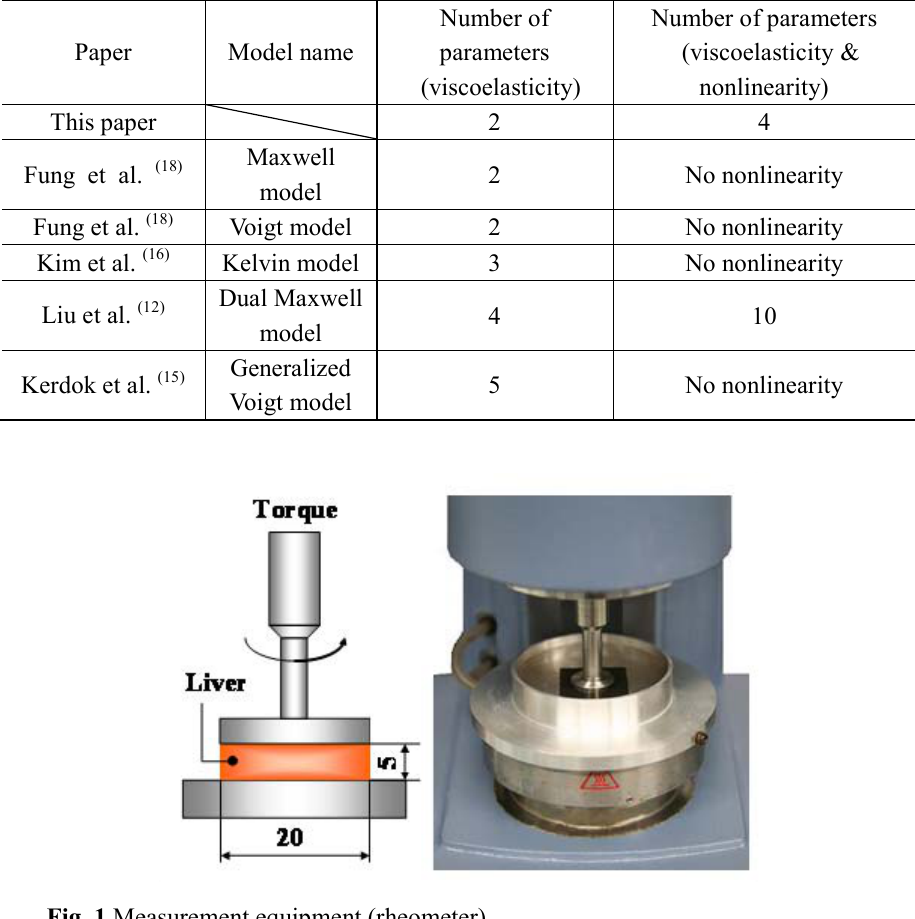
Fig. 1 Measurement equipment